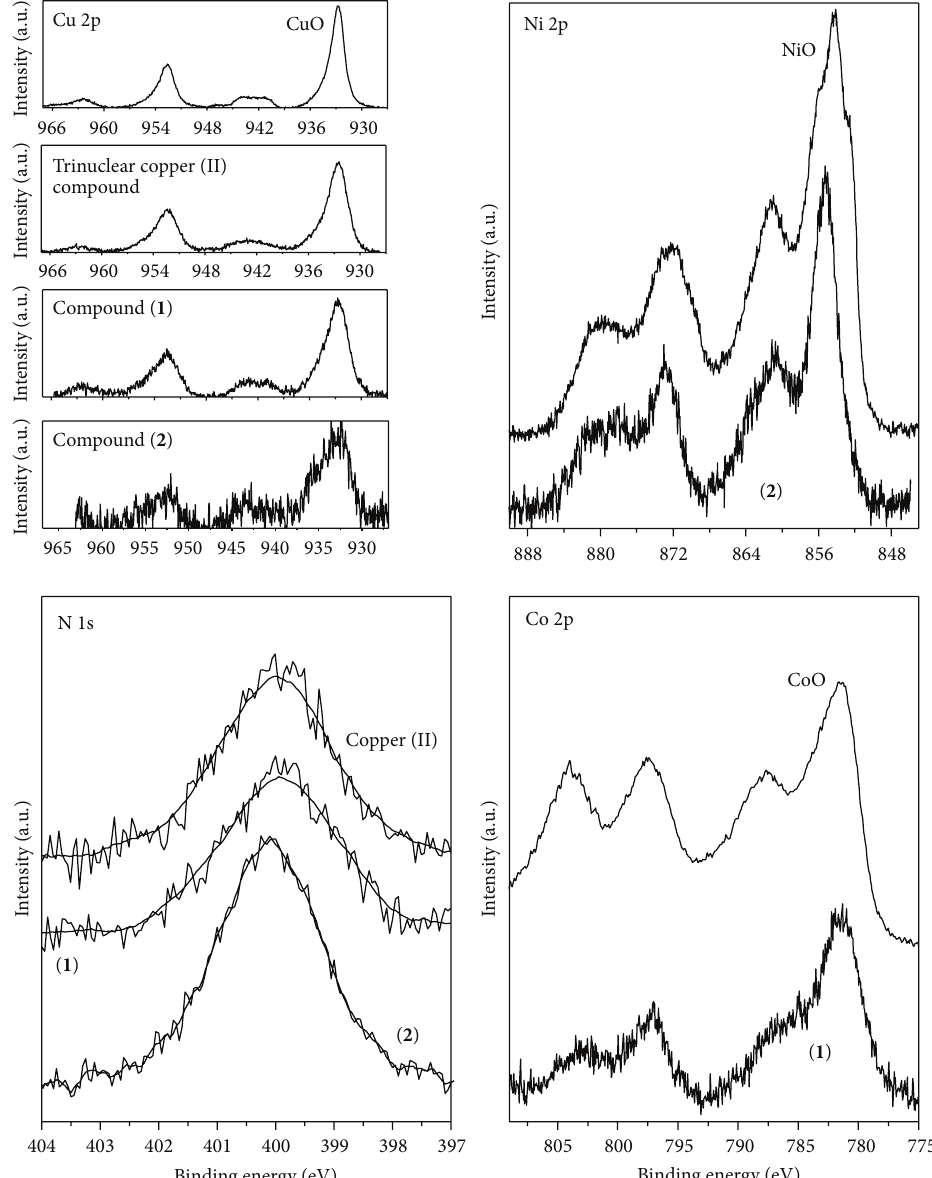
Figure 8: XPS spectra of Cu 2p, Ni 2p, Co 2p, and N 1s core level. Compared with the XPS spectra of the homotrinuclear and heterotrinuclear compounds ( 1 ) and ( 2